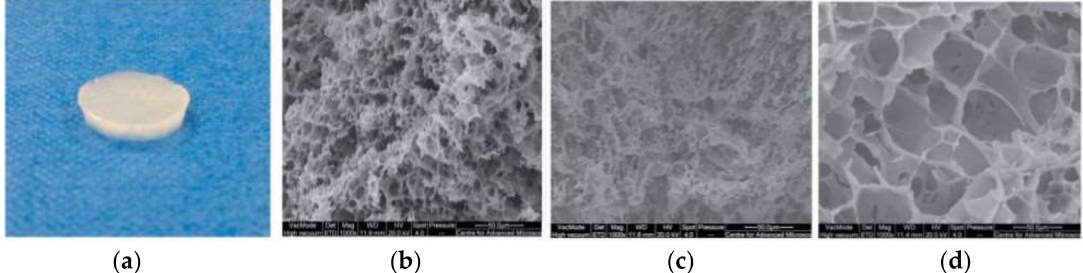
Figure 16. Optic image of swollen cryogel with 0.8% NaOH ( a ) and scanning electron microscopy images of poly(vinyl alcohol)–Gantrez ® AN based cryogels in the presence of 0.4% ( b ), 0.6% ( c ) and 0.8% NaOH ( d ). Republished with permission from [90]. Copyright 2016 the Royal Society of